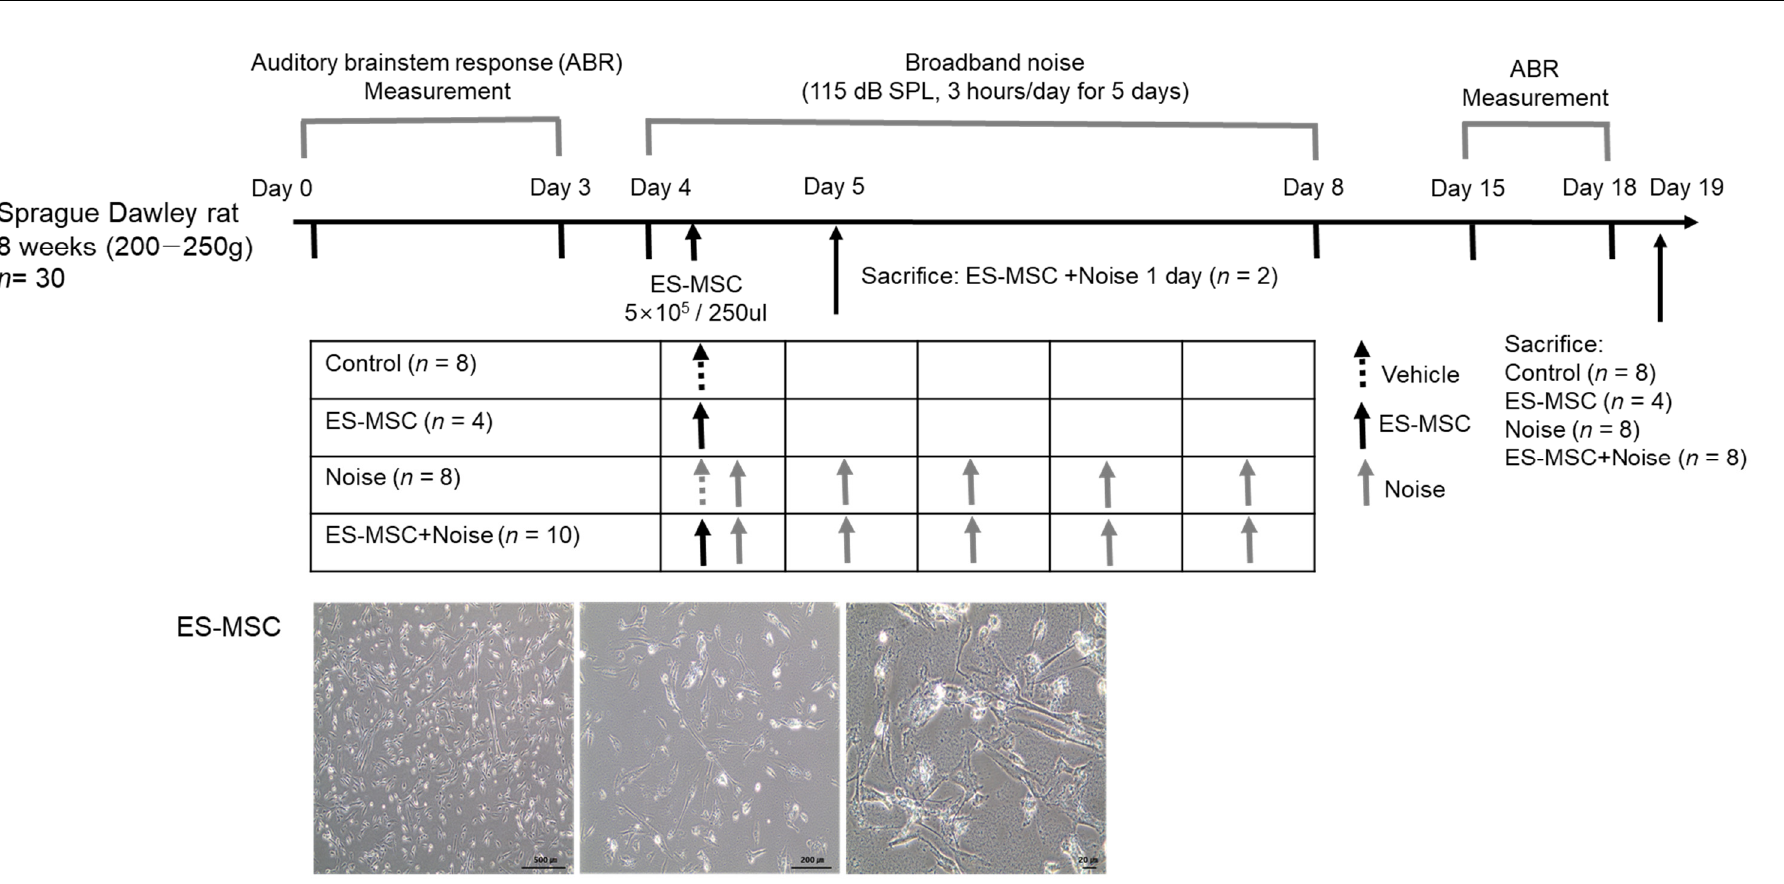
Figure 1. The experimental schedule of the present study. Adult rats were randomly divided into four groups: control, embryonic stem cell-derived mesenchymal stem cells (ES-MSCs), noise, and ES-MSC+noise rats. ES-MSCs were injected at day 4 via the tail vein. Then, broadband noise was exposed for 5 days. The auditory brainstem response (ABR) thresholds were measured before and after treatments. The lower panel showed representative morphologies of the ES-MSCs at different magnifications. The cultured ES-MSCs were injected into rats via the tail vein.